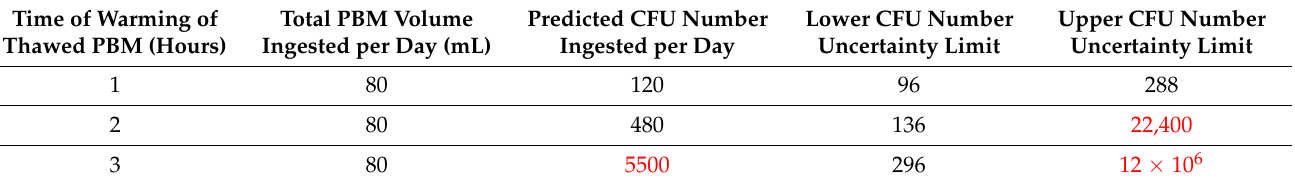
Table 6. The predicted number of B. cereus CFU ingested per day for initial post-pasteurization concentration of 1 CFU/mL after 1, 2 and 3 h of